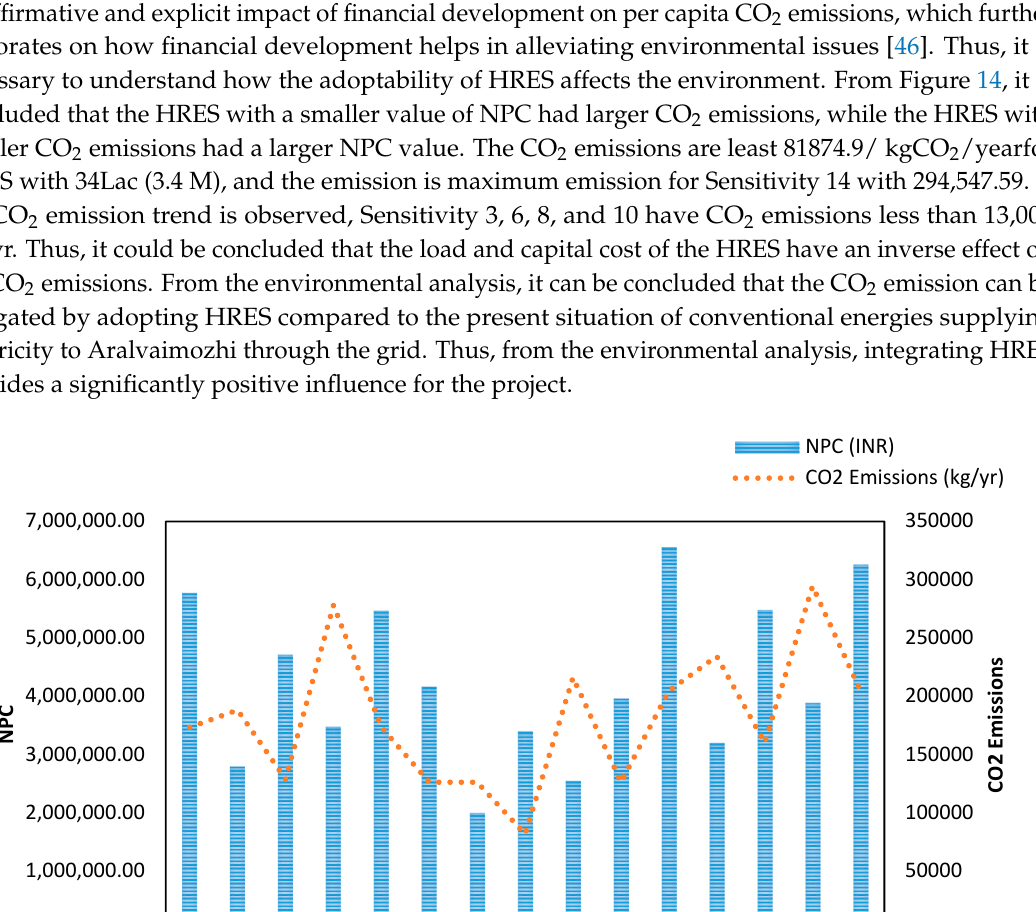
Table 3. Results of all sensitive cases with the lowest value of NPC.